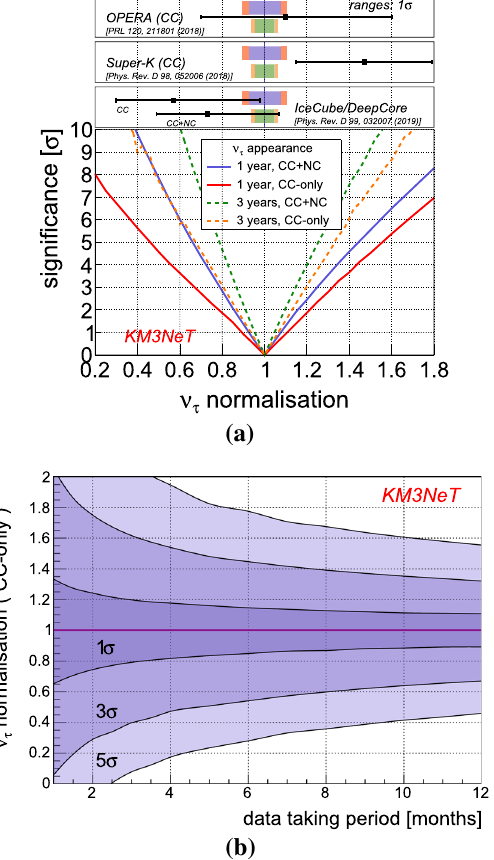
(cid:5)(cid:6)ν Fig. 12 Sensitivity to τ appearance for CC and CC+NC normalisa- tion scaling after 1 and 3 years of operation ( a ). Measurements from other experiments [18–20] at 1 σ level are shown for comparison. In b , (cid:5)(cid:6)ν τ appearance sensitivity for CC scaling is presented as a function of data taking